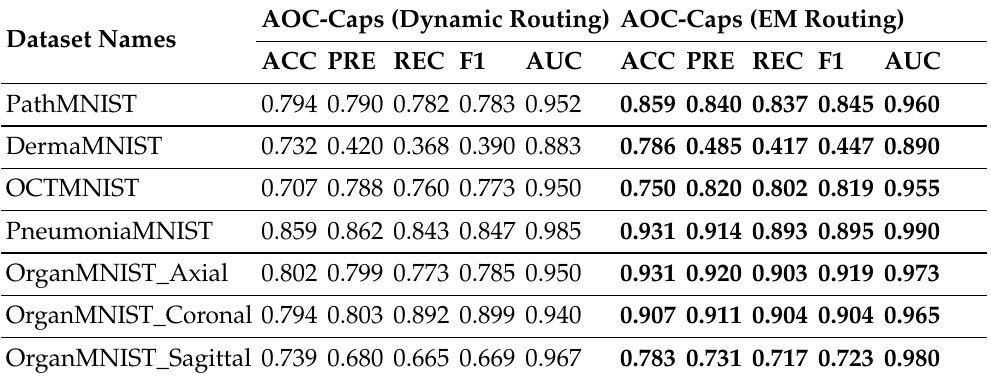
Table 9. Performance of different capsule forms and routing.